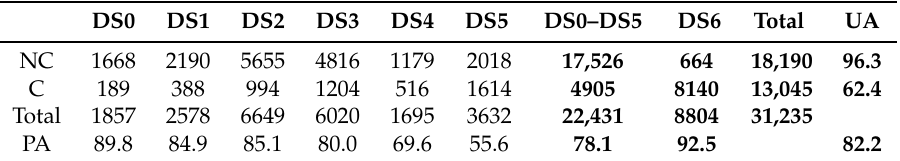
Table 1. Accuracy evaluation of the classification results for collapsed and non-collapsed buildings obtained using a linear discriminant function based on the fragility function of Koshimura et al. [26].